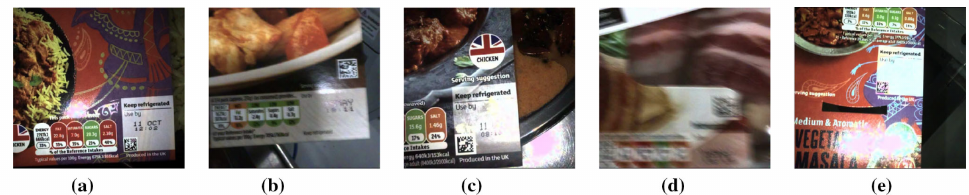
Figure 8. Representative examples of food packaging images: ( a ) complete date (day and month visible); ( b ) partial date (no day visible); ( c ) partial date (no month visible); ( d ) unreadable; ( e ) uo date.